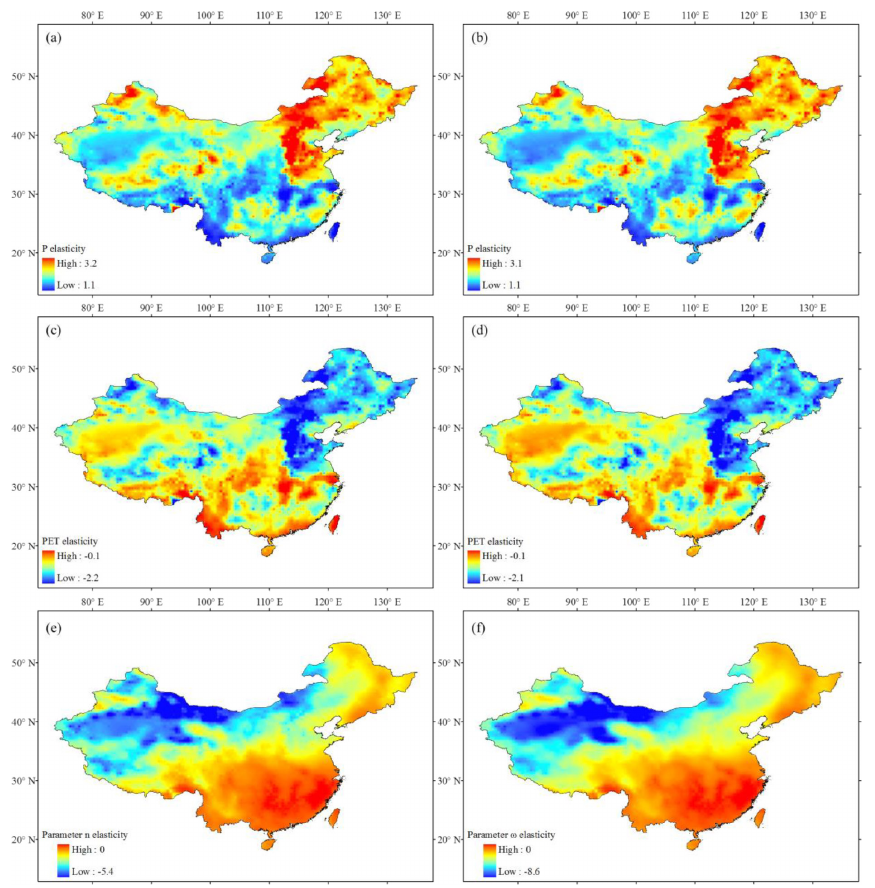
Figure 5. Spatial distributions of the P elasticity of R across China from (a) Eq. (2) and (b) Eq. (3). Spatial distributions of the PET elasticity of R across China from (c) Eq. (2) and (d) Eq. (3). Spatial distributions of the parameter elasticity of R across China from (e) Eq. (2) and (f) Eq.